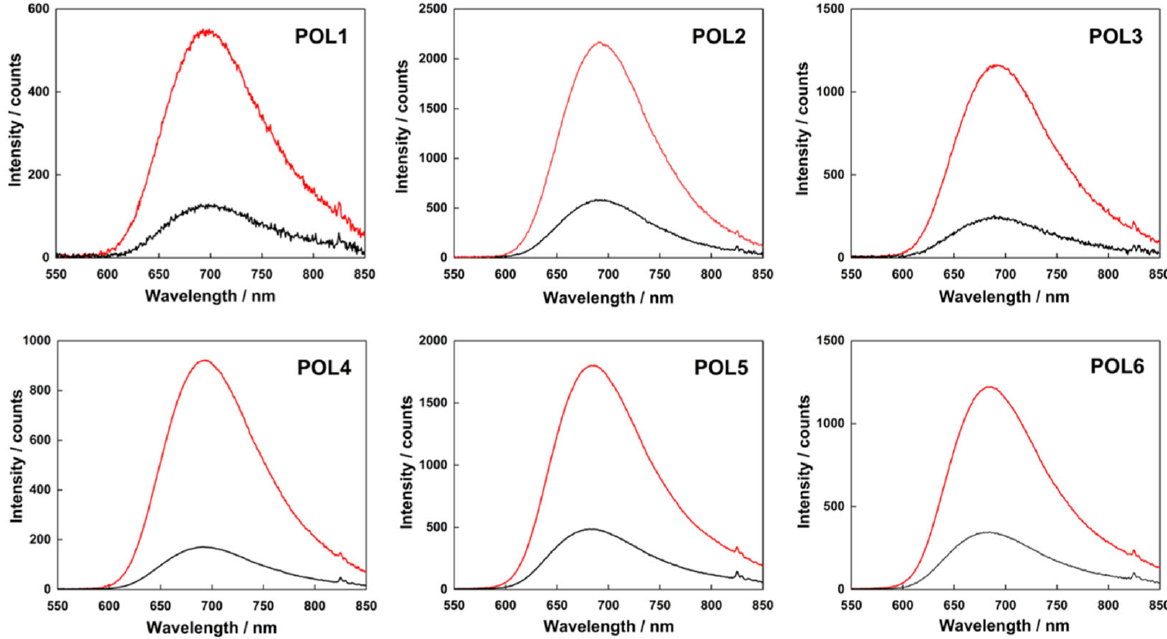
Figure 4. Luminescence emission spectra of POL1 – POL6 in deionized water: argon-saturated (red curve) and air-saturated (black curve) dispersions. All samples were excited at 400 nm.